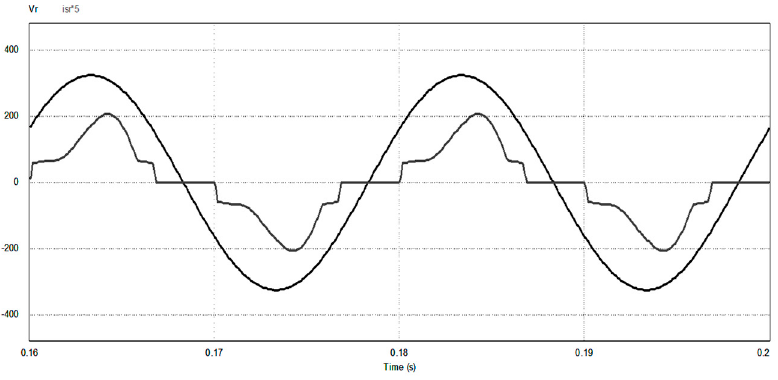
Figure 10. Case A—voltage and current on phase R . Figure 10. Case A - voltage and current on phase R . Figure 10. Case A - voltage and current on phase R .